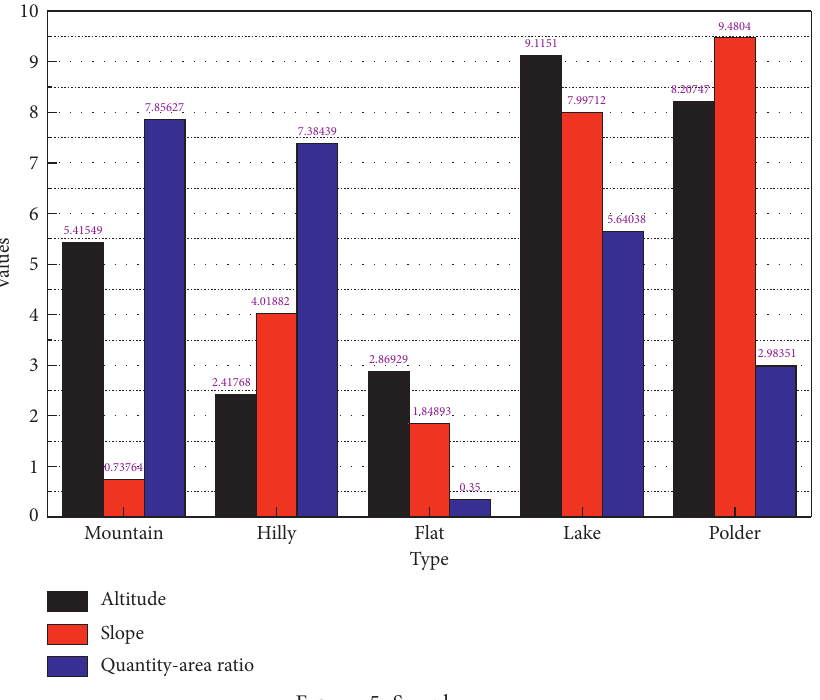
Figure 5: Sample